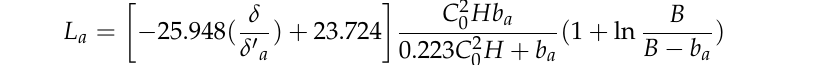
Figure 20. The relationship between L a / L (cid:48) a and δ / δ (cid:48) a when groin B is in the near-field of groin A. According to the linear fitting formula in Figure 20, Equation (11) can be written as: L a δ = − 25.948 ( ) + 23.724 (15) L (cid:48) a δ (cid:48) a Furthermore, Equation (4) is substituted into Equation (15), and the length of recircu- lation zone behind Groin A can be obtained as: L a = When Groin B is at downstream far field of Groin A, the relationship diagram of L a / L (cid:48) a ~ δ / δ (cid:48) a is presented in Figure 21.